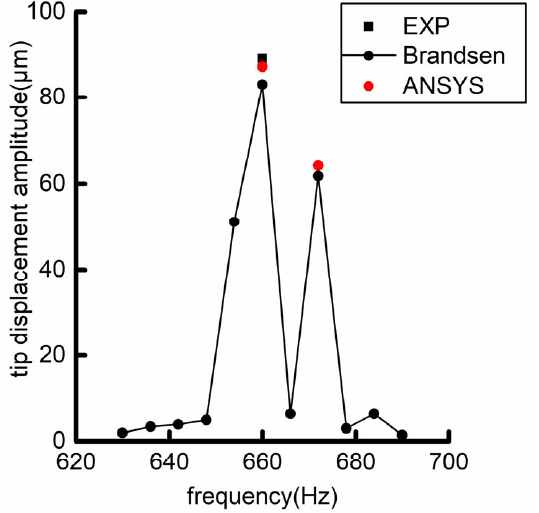
Figure 9. Results of forced vibration calculation and test for a compressor.